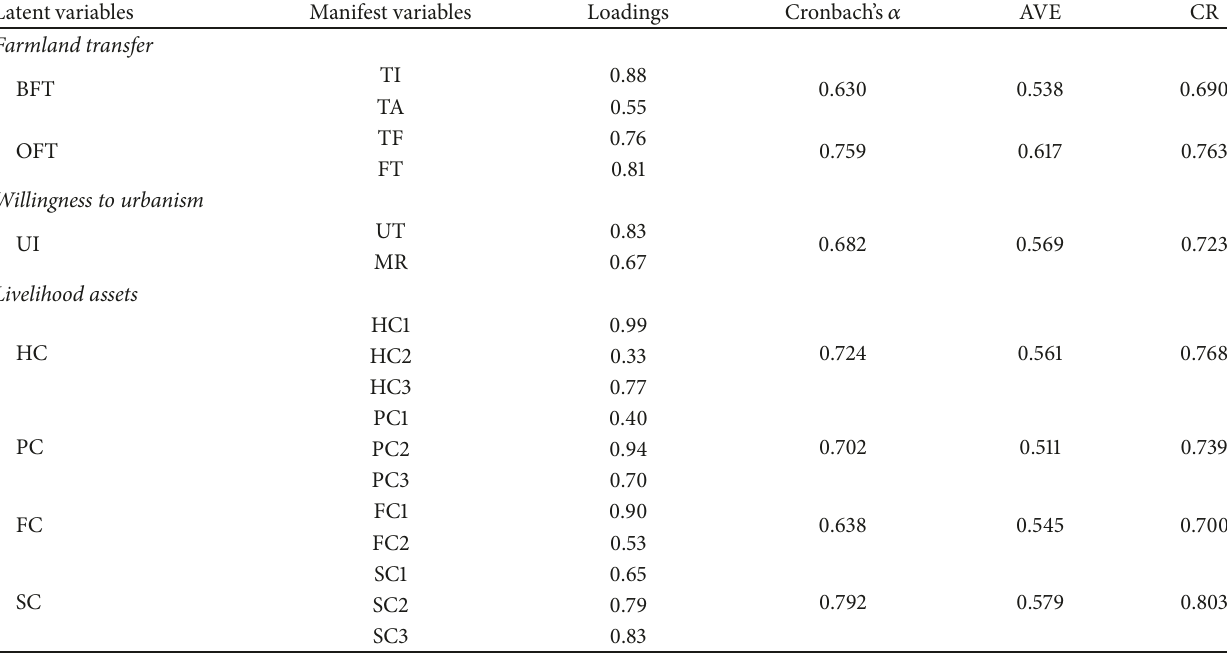
Table 4: Reliability of the manifest variables.